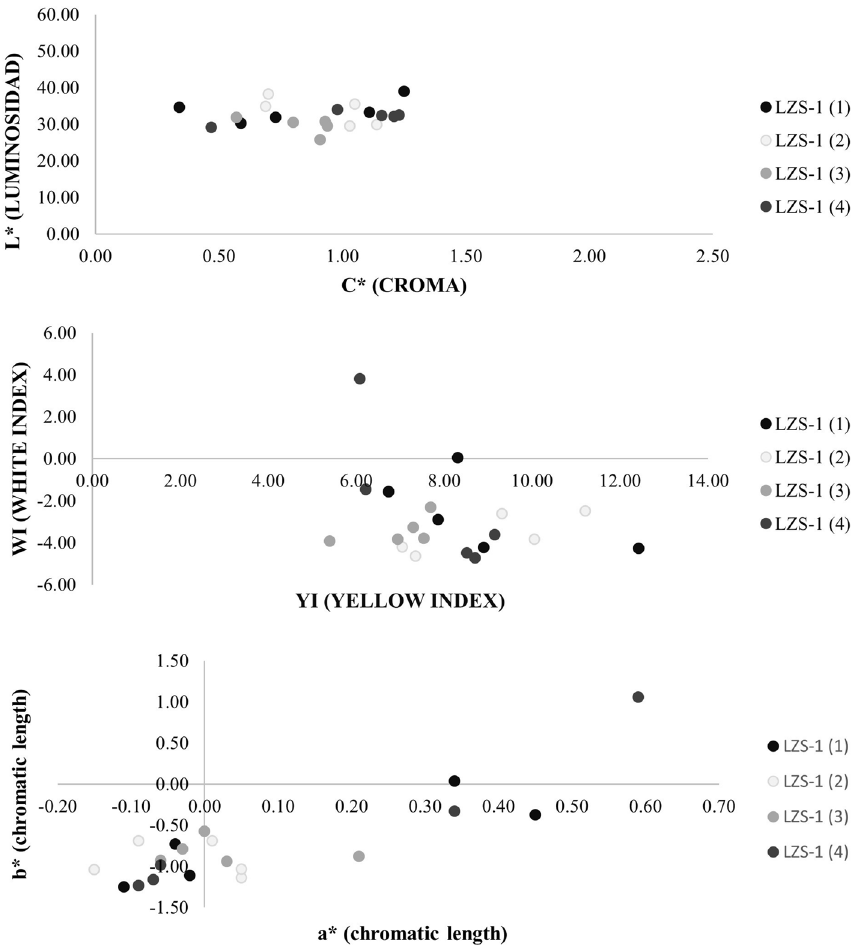
Figure 9. Data from colour test where it can be observed that there is hardly any dispersion between the analysed samples and therefore it can be said that they have not been altered by weathering processes after the eruption.